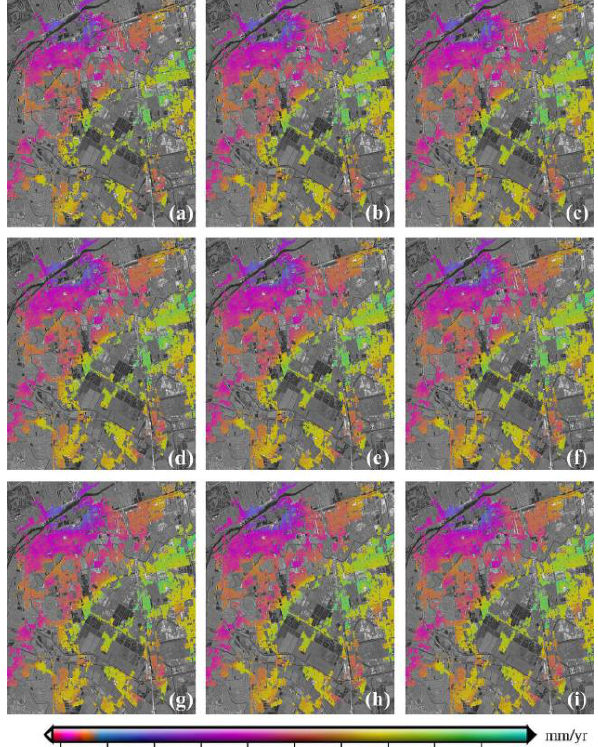
Figure 4. The subsidence rates expanded for the study area. (a)– (i) depicts the combined subsidence rates obtained from the previous and current groups, respectively. For example, (a) is obtained from Groups 0–1, and (i) from Groups